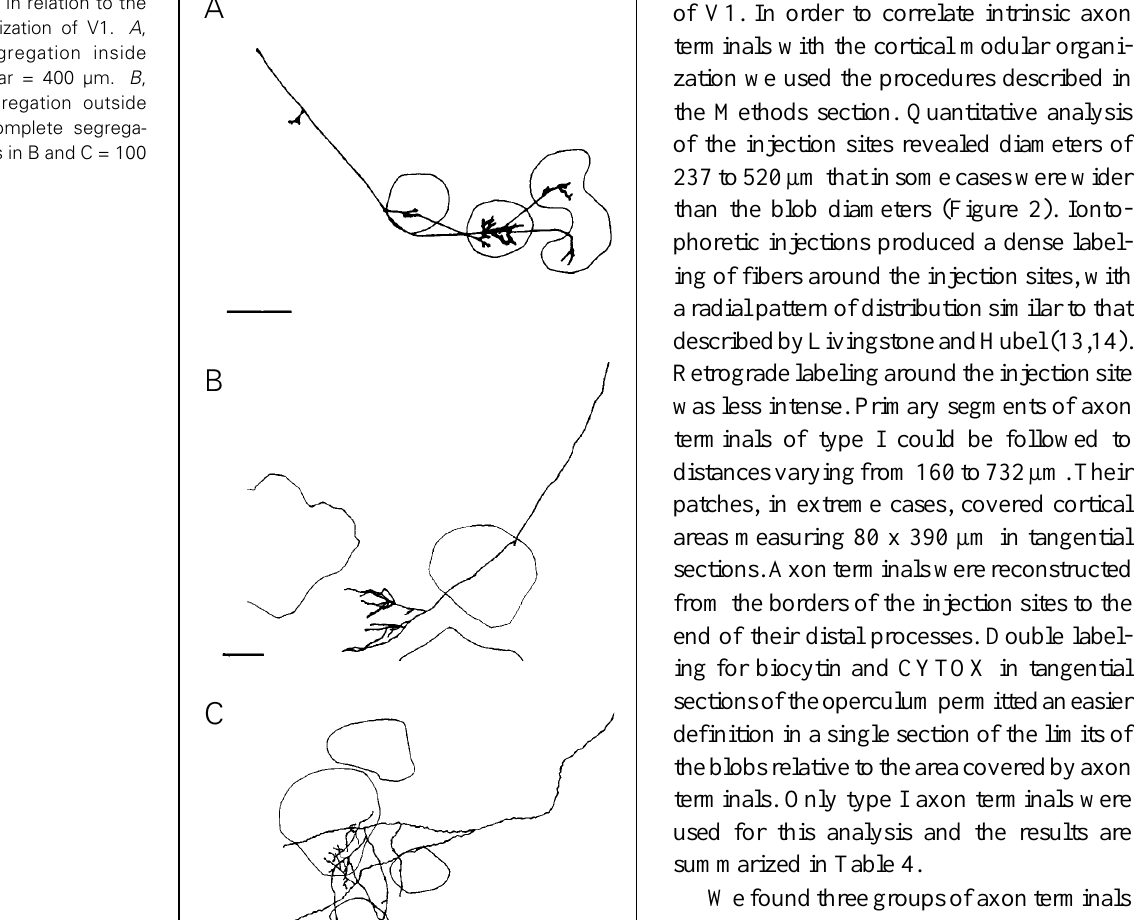
Figure 8 - 3-D reconstructions of axon terminals in relation to the modular organization of V1. A , Complete segregation inside blobs. Scale bar = 400 µm. B , Complete segregation outside blobs. C , Incomplete segrega- tion. Scale bars in B and C = 100 µm.